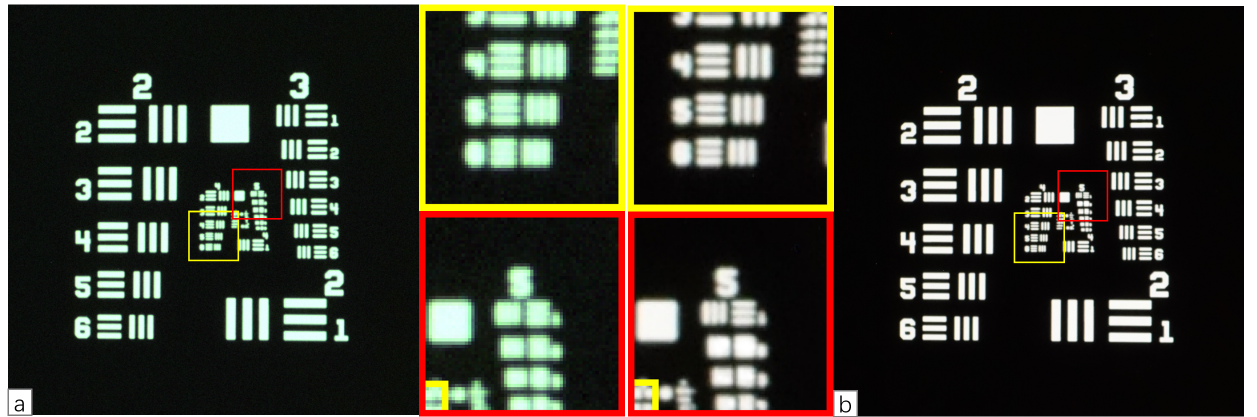
Figure 7. SHDCIS imaging test of resolution target; ( a ) is the image captured directly by the detector; ( b ) is the image reconstructed by the DDZMR network.